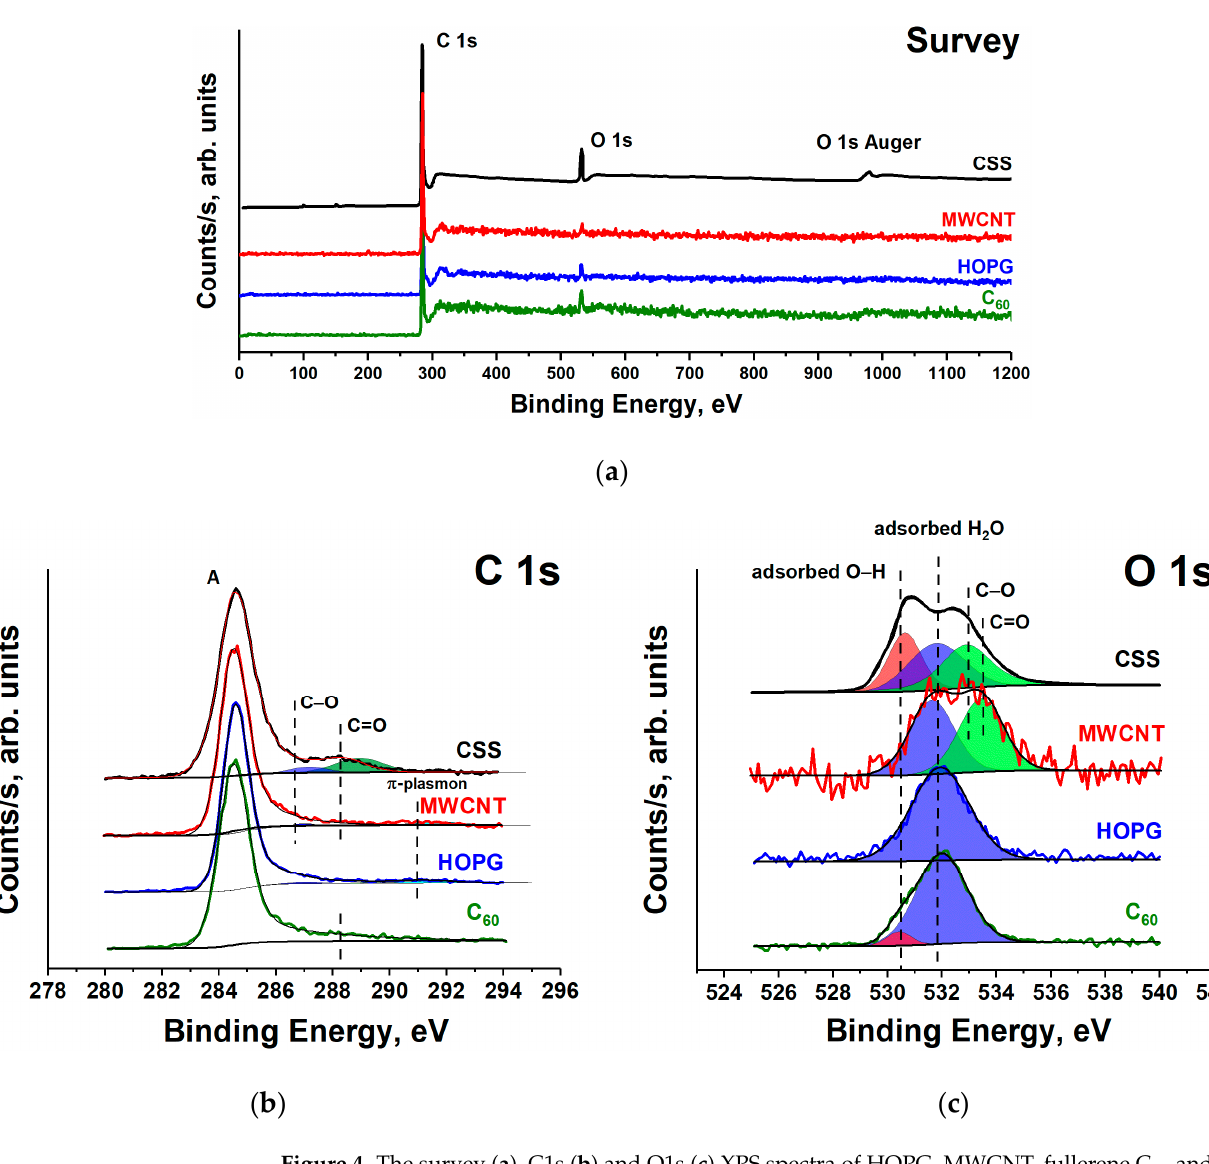
Figure 4. The survey ( a ), C1s ( b ) and O1s ( c ) XPS spectra of HOPG, MWCNT, fullerene C 60 and CSS.